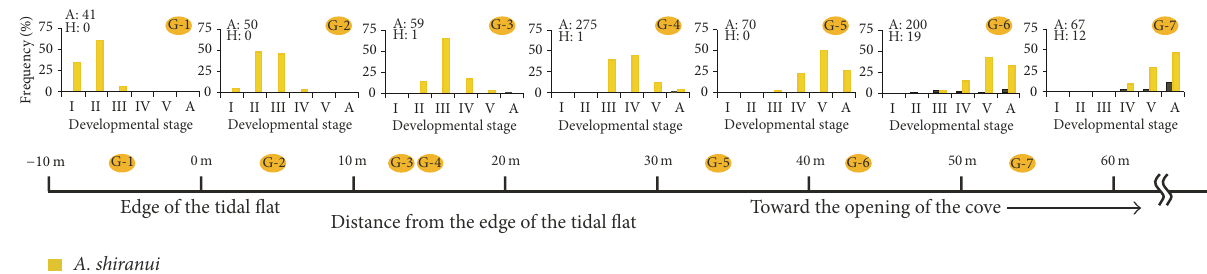
Figure 5: Composition of developmental stages of A. shiranui and H.matsumurai of each aggregation (G1–G7) formed on tidal pools or along the seashore at varying distances from the waterfront edge of the tidal flat. A: the total number of A. shiranui and H: the total number of H. matsumurai at each